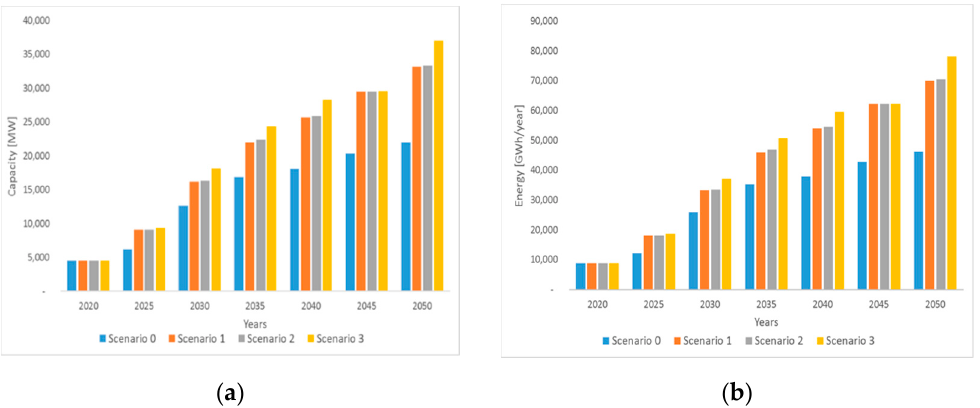
Figure 3. Evolution of the installed capacity ( a ) and energy generation ( b ) of PV and wind under Scenarios 1, 2 and 3.